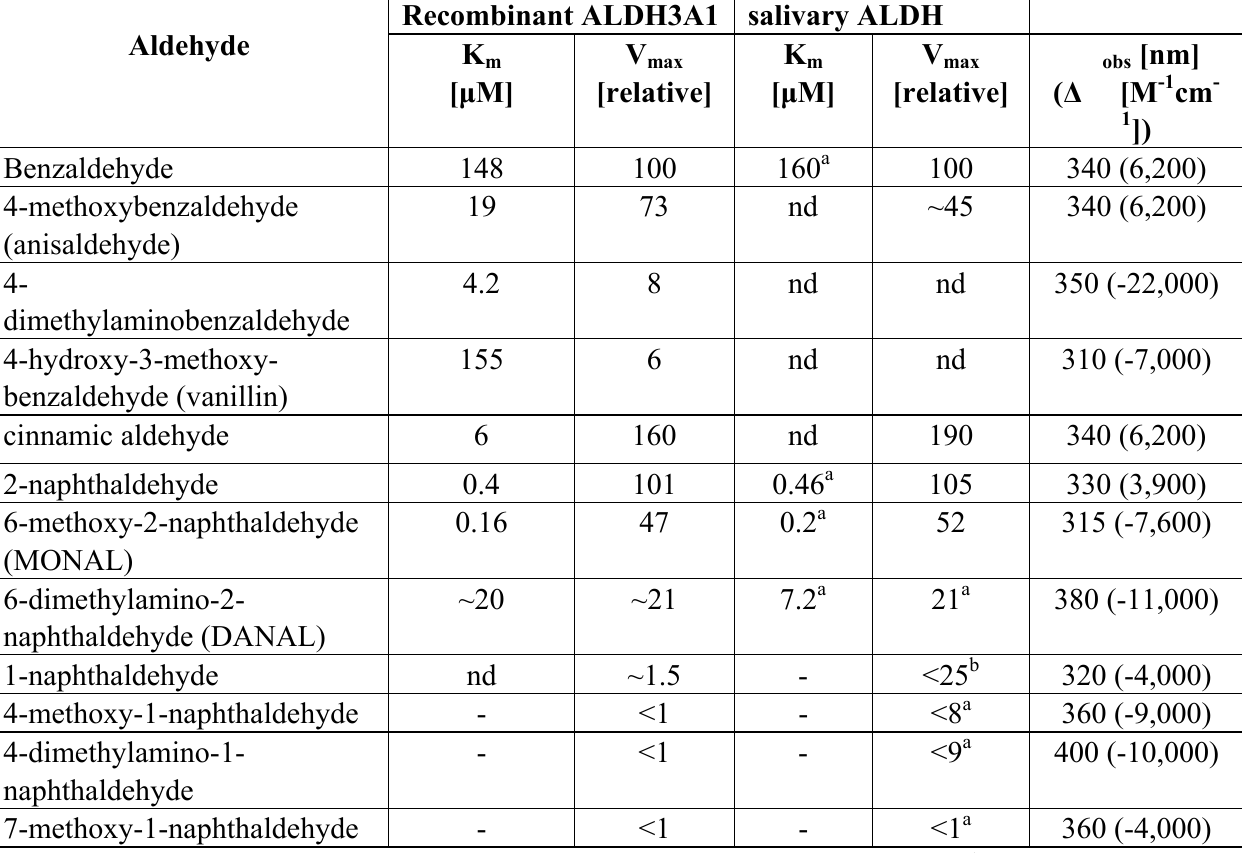
Table 1. Kinetic parameters, determined spectrophotometrically or fluorimetrically, for enzymatic oxidation of aromatic aldehydes by recombinant ALDH3A1, compared to those for salivary ALDH. Maximal rates are measured relative to that of benzaldehyde